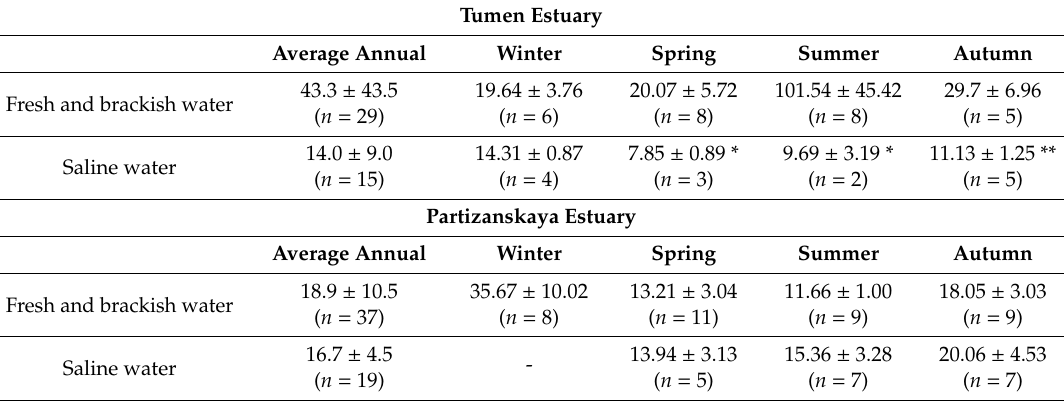
Table 2. Average annual and seasonal TPAHs concentrations (ng / L) in the fresh and saline waters of the Tumen River Estuary and the Partizanskaya River